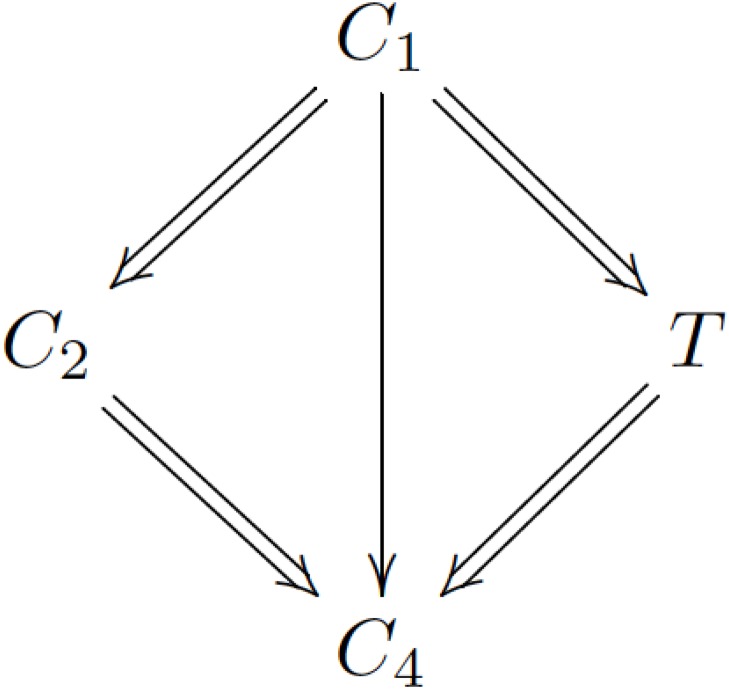
Illustration of the example in Section 4.2.1.